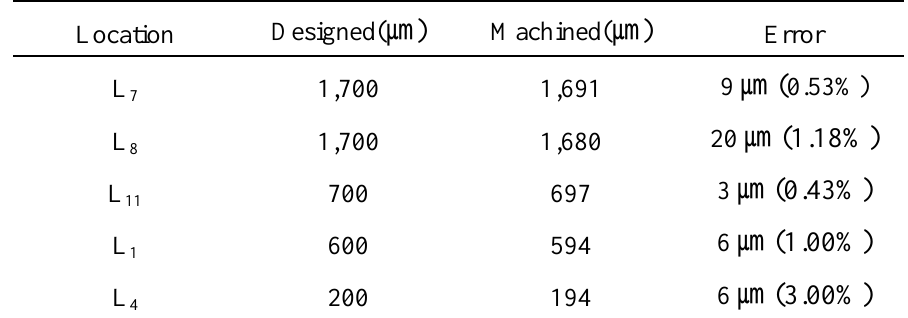
Figure 11. Error estimation of the fabricated sensor. Table 4. Error estimation